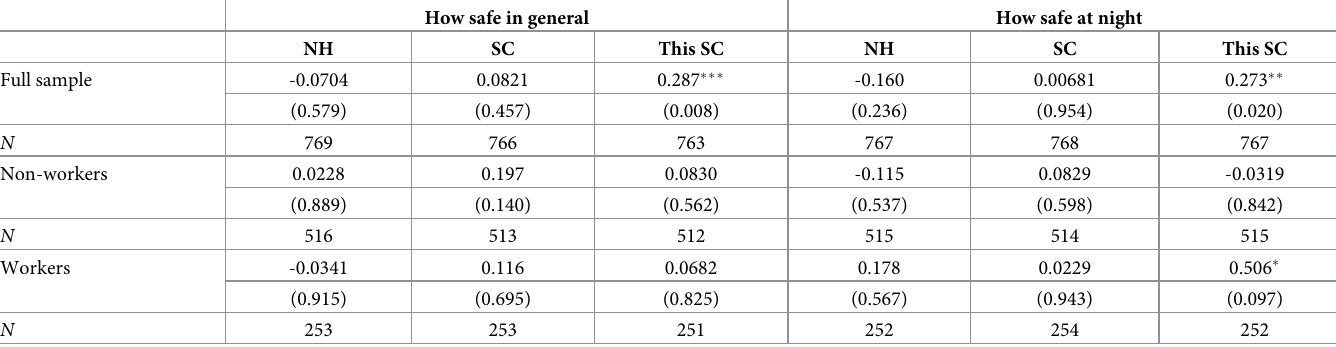
Table 3. Difference-in-differences estimates of the effect on fear of